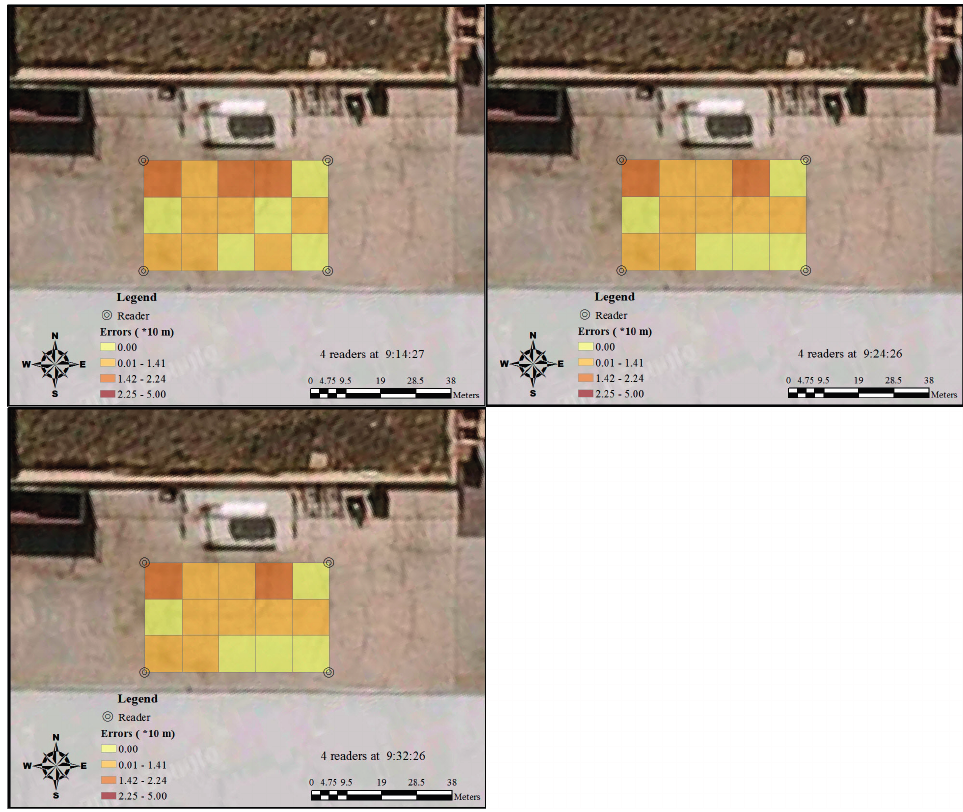
Figure 5. Temporal variation of RFID errors distribution in the discrete grids by four readers.